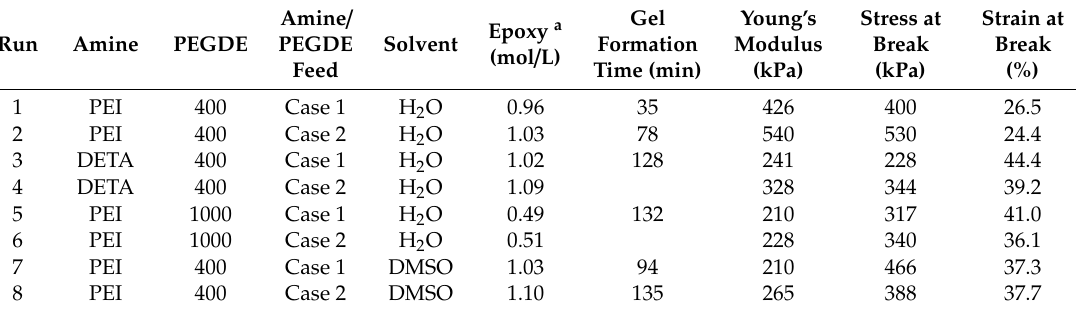
Table 1. Gel formation time and mechanical properties of polyethyleneimine (PEI) or diethylenetriamine (DETA)-polyethylene glycol diglycidyl ether (PEGDE) gels, monomer concentration: 30 wt%. DMSO, dimethyl